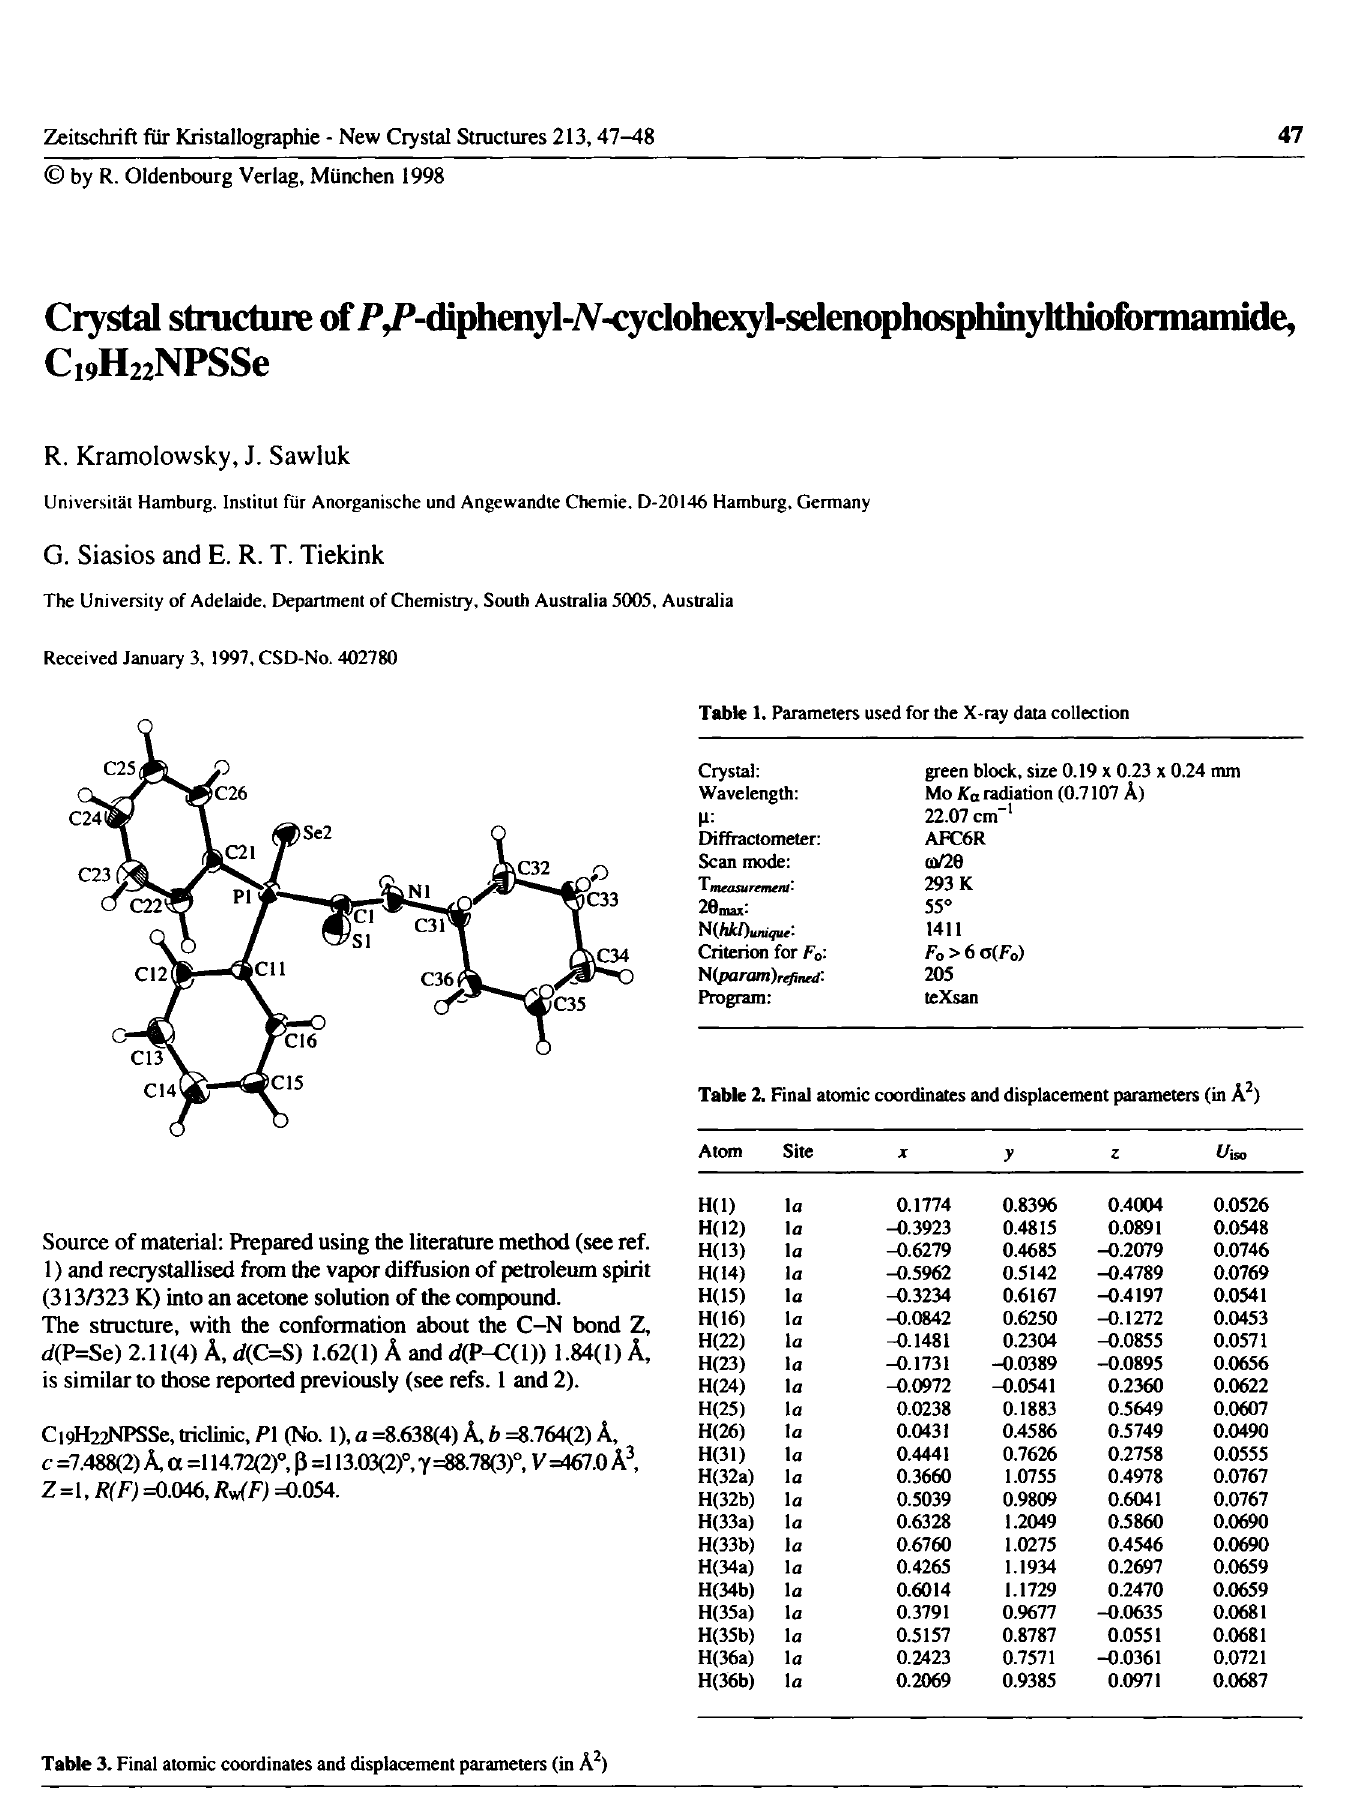
Table 3. Final atomic coordinates and displacement parameters (in Â^)